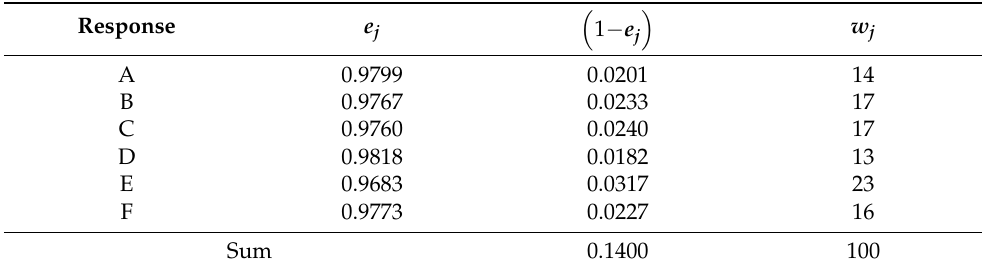
Table 6. Calculation of weightages of output